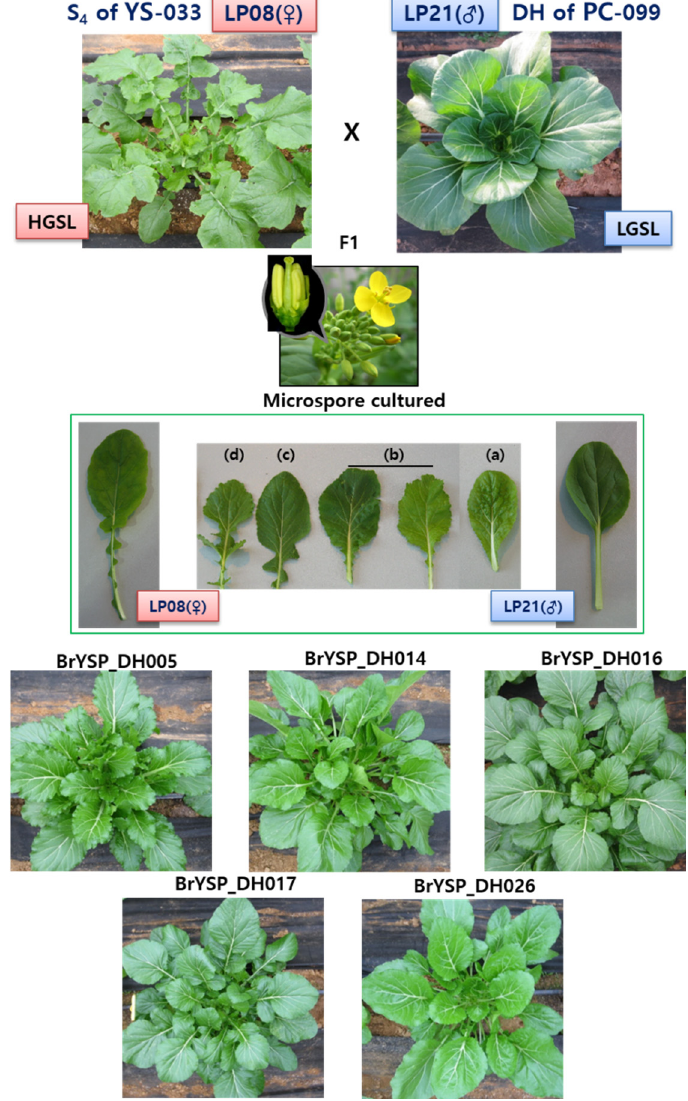
Figure 2. Development strategy of high glucosinolate synthesis lines using hybrid plants from different B. rapa subspecies.